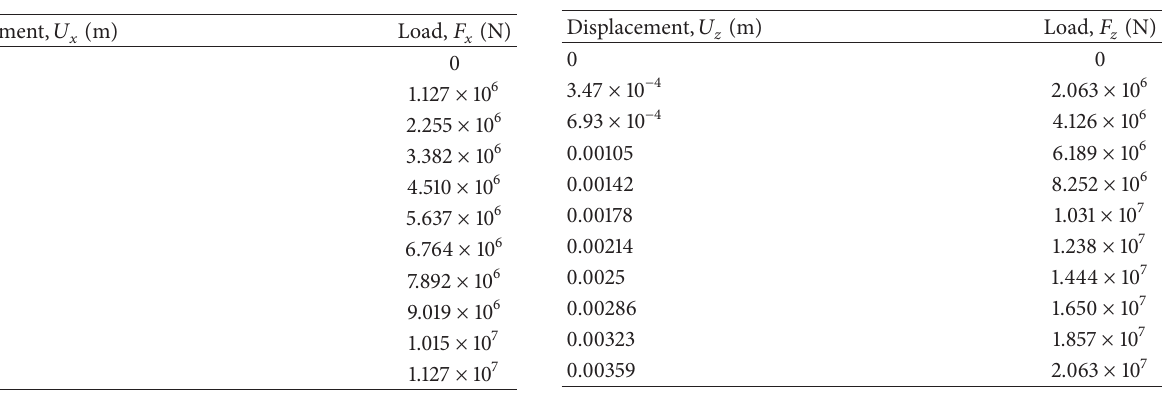
Table 7: Stiffness for 𝐹 𝑥 versus 𝑈 𝑥 ( 𝐹 𝑦 versus 𝑈 𝑦 ). Table 8: Stiffness for 𝐹 𝑧 versus 𝑈 𝑧